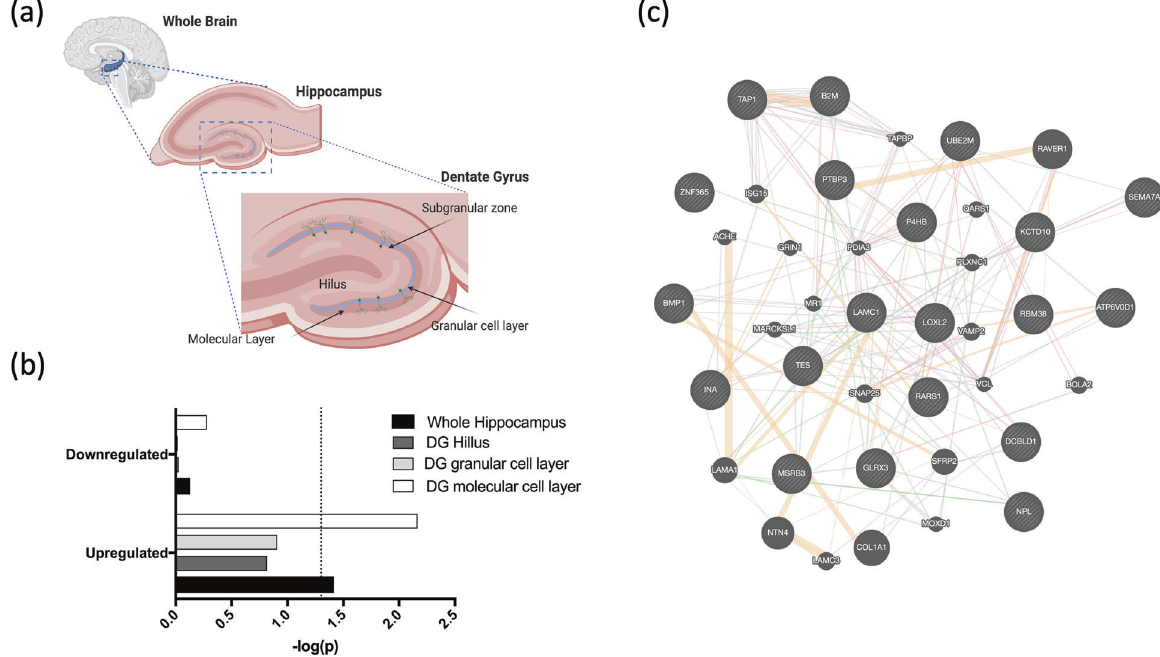
Fig. 5 Lithium ’ s effect on the expression of genes in hippocampal progenitors and its overlap with genes regulating the volume of the dentate gyrus. a The anatomy of the hippocampus, including the dentate gyrus where adult neurogenesis occurs. b A bar chart illustrating the results from our gene-set enrichment analyses. Gene sets comprise of upregulated and downregulated genes ( P FDR < 0.05) in response to the high lithium dose. These sets of genes were tested for overlap with those implicated in the regulation of whole hippocampal volume and the volume of dentate gyrus (DG) sub fi elds where neurogenesis takes place. Stronger signi fi cance is indicated by a larger bar, and -log( p ) value. The dashed line represents the nominal signi fi cance threshold ( p = 0.05). The overlap between genes upregulated in response to lithium and those regulating the size of the molecular cell layer of the dentate gyrus was the only test that remained signi fi cant after multiple testing correction ( P FDR < 0.1). c A gene network image generated using GeneMANIA. This describes genes signi fi cantly affected by lithium in our hippocampal progenitor cell model ( P FDR < 0.05), which were also associated with volume in the molecular layer based on gene-level enrichment analyses ( P < 0.05). Lines represent expected interactions between genes (orange = predicted interactions, purple = interactions based on co-expression, pink = physical interactions, blue = interactions based on colocalization, green = genetic interactions, yellow = shared protein domains). Genes input into GeneMANIA are represented by circles with diagonal lines, genes hypothetically interacting within this network are represented by solid circles. LAMC1 interacted with the most genes relative to other genes input into GeneMANIA, suggesting it might represent an important hub